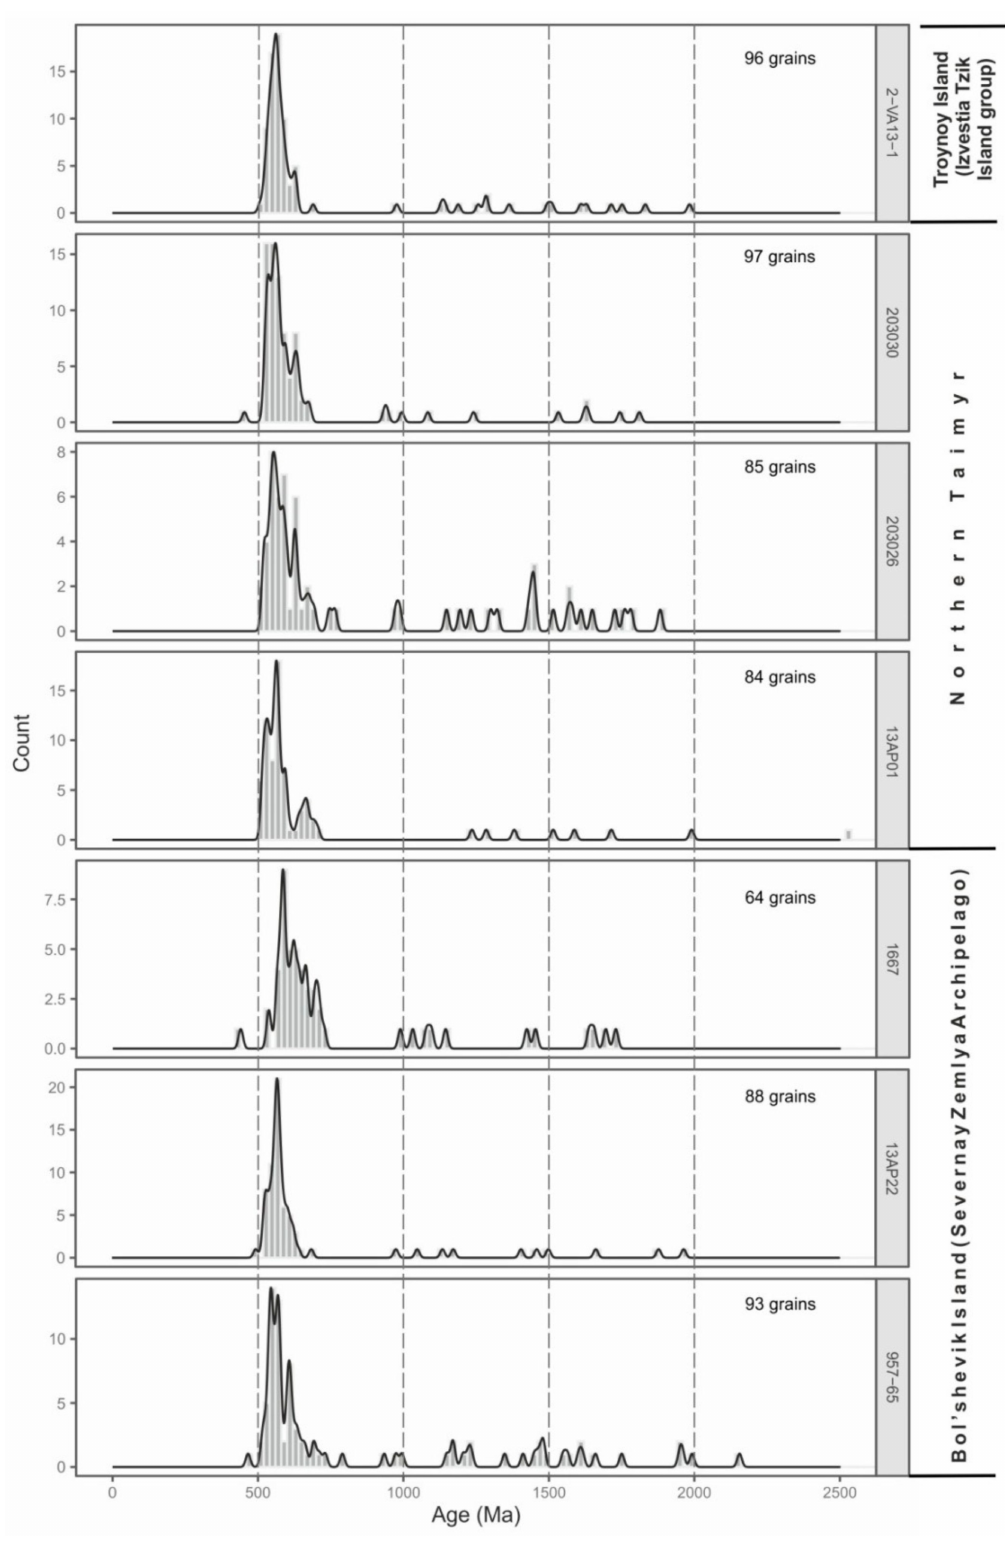
Figure 3. Combined histogram and kernel density estimate plots of all dated samples. Ages are given as 206 Pb– 238 U ages if equal to or younger than 1000 Ma; otherwise, the 207 Pb– 206 Pb ages have been used. Diagrams were produced in detzrcr, an R-package developed by Kristo ff ersen et al. (2016)